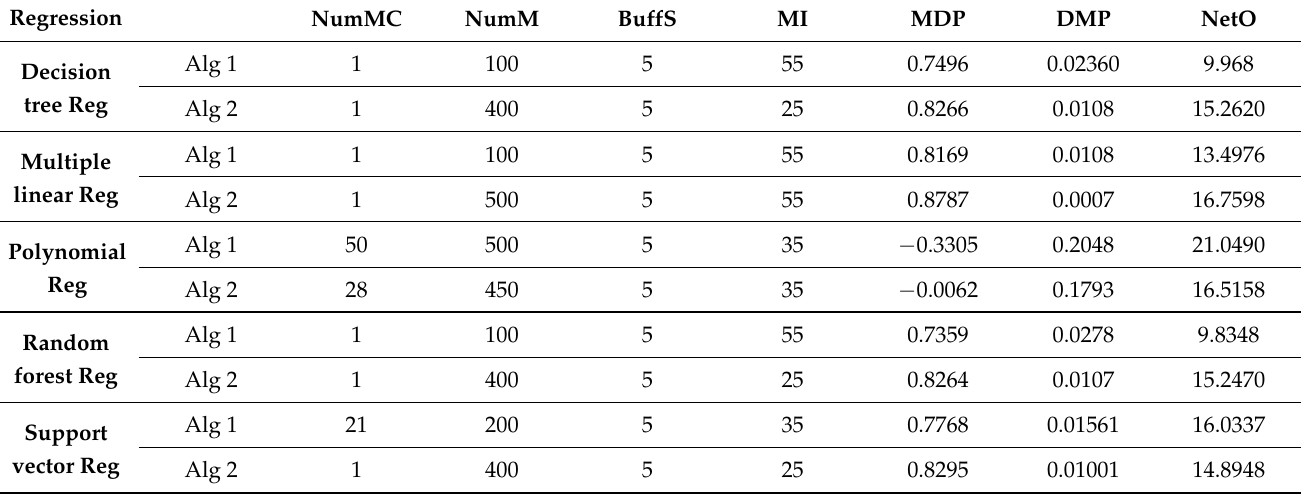
Table 6. The optimal results by BuffS = 5 based on Algorithms 1 and 2 for regression